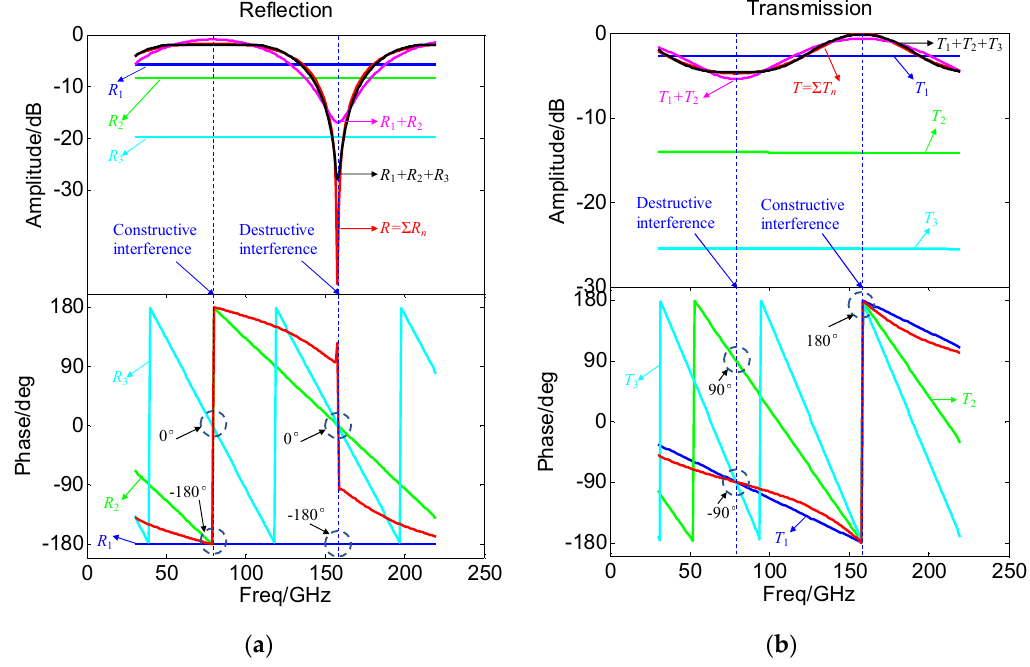
= 10 − j0.01. ( a ) Reflection; ( b ) r